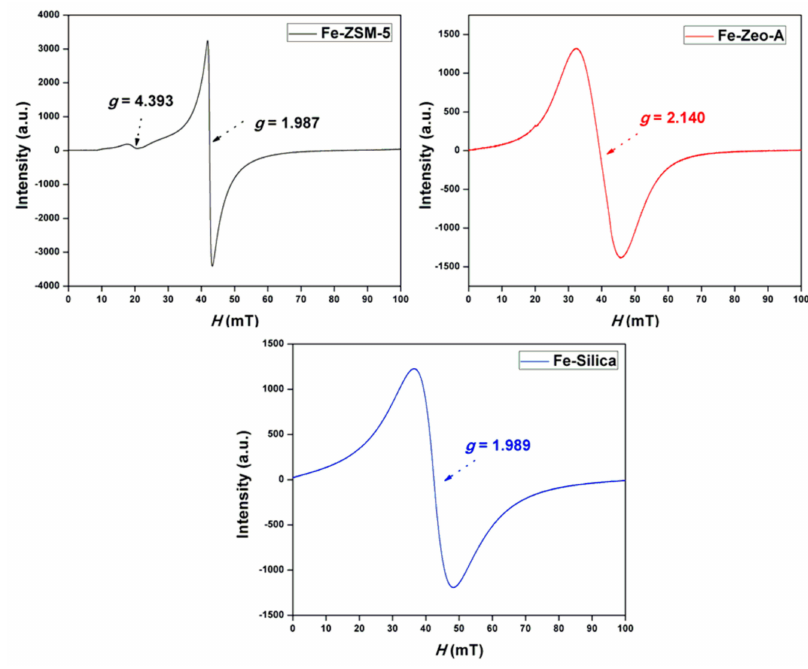
Figure 4. Electron paramagnetic resonance (EPR) spectra of Fe-ZSM-5, Fe-Zeo-A, and Fe-Silica at 77 K.